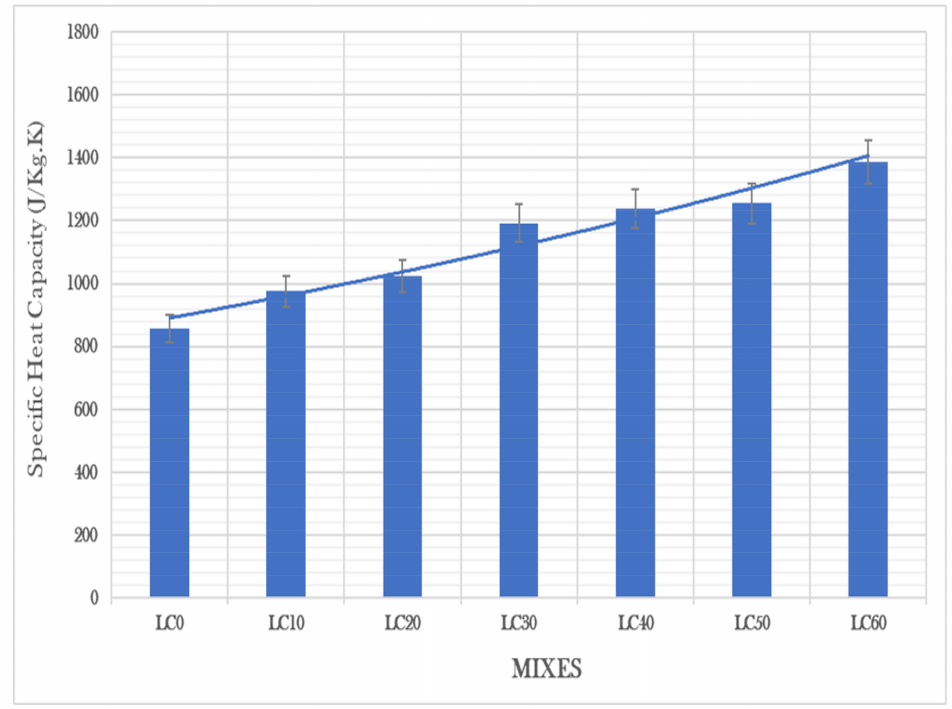
Figure 10. Effect of EPA aggregate dosage on specific heat capacity of concrete